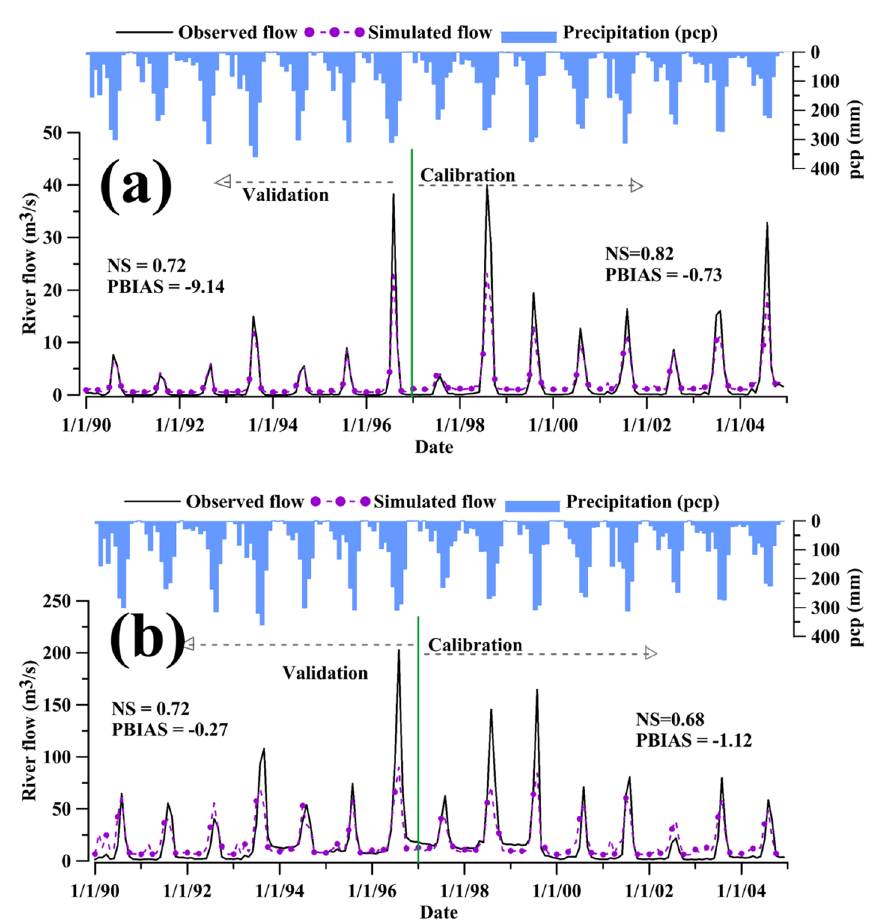
Figure 5. Calibration and validation of river flow at Little Akaki ( a ) and Big Akaki ( b ) gauging stations and the average precipitation in the study